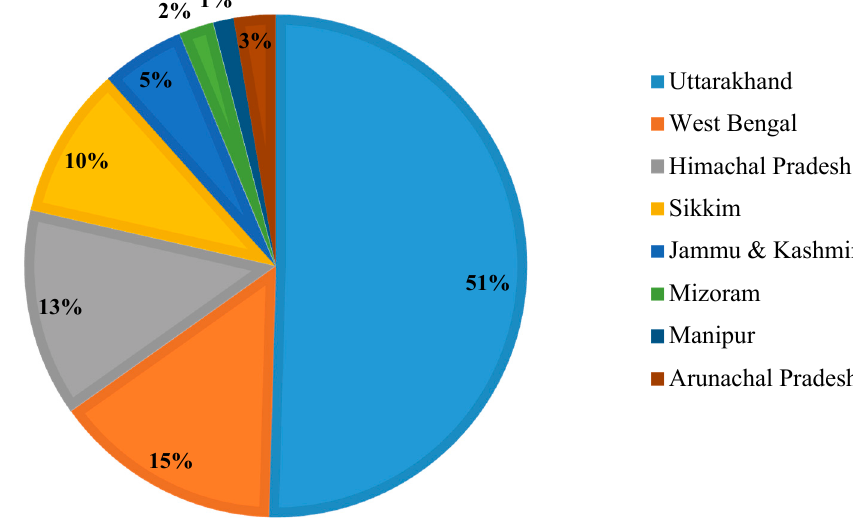
Figure 5. Distribution of landslide studies across the states in Indian Himalayan region.